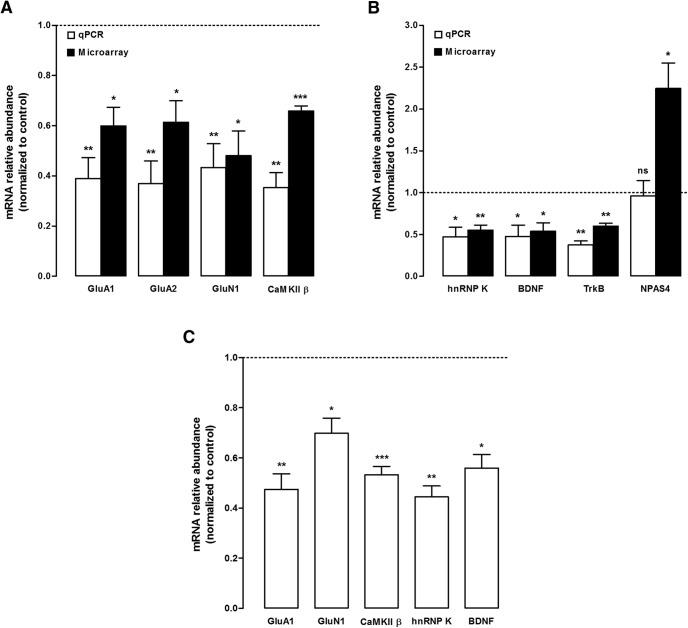
BDNF induces the dissociation of mRNA from hnRNP K at the synapse. A, B, Effect of BDNF stimulation (50 ng/ml; 10 min) on transcript coimmunoprecipitation with hnRNP K in cultured hippocampal neurons as assessed by microarray and qPCR. The specificity of transcripts associated with hnRNP K was assessed by subtracting the levels of correspondent mRNAs pulled down together with mouse IgG antibodies. hnRNP K-associated mRNAs were then compared between control and BDNF treated neurons. A, Genes coding for synaptic proteins: GluA1, AMPA receptor subunit 1; GluA2, AMPA receptor subunit 2; GluN1, NMDAR subunit 1. B, Other genes: TrkB, tropomyosin-related kinase B receptor; NPAS4, neuronal PAS domain protein 4. The results represent quantitation of four different experiments performed in independent preparations, and are expressed as percentage [mean ± SEM (qPCR) or SD (microarray)] of control; *p < 0.05, **p < 0.01, ***p < 0.001 as determined by ANOVA followed by Dunnett’s multiple comparison test (qPCR) or using the paired Student’s t test (microarray). C, BDNF decreases the interaction of hnRNP K with mRNAs coding for synaptic proteins in hippocampal synaptoneurosomes. Synaptoneurosomes were stimulated or not with BDNF (50 ng/ml) for 10 min and the mRNA levels coimmunoprecipitated with hnRNP K (control and BDNF-treated synaptoneurosomes) were normalized to the correspondent IgG-pulled down mRNA to exclude any unspecific binding. Transcripts that were specifically associated with hnRNP K were then compared between control and BDNF-stimulated synaptoneurosomes. The relative abundance of each transcript was evaluated by qPCR. Results were normalized for mRNA expression under control conditions and are the average of at least four independent experiments. Statistical analysis was performed by one-way ANOVA followed by the Bonferroni’s multiple comparison test; *p < 0.05; **p < 0.01;***p < 0.001. Extended data Figure 3-1 shows the characterization of the synaptosomal preparation, using specific protein markers.